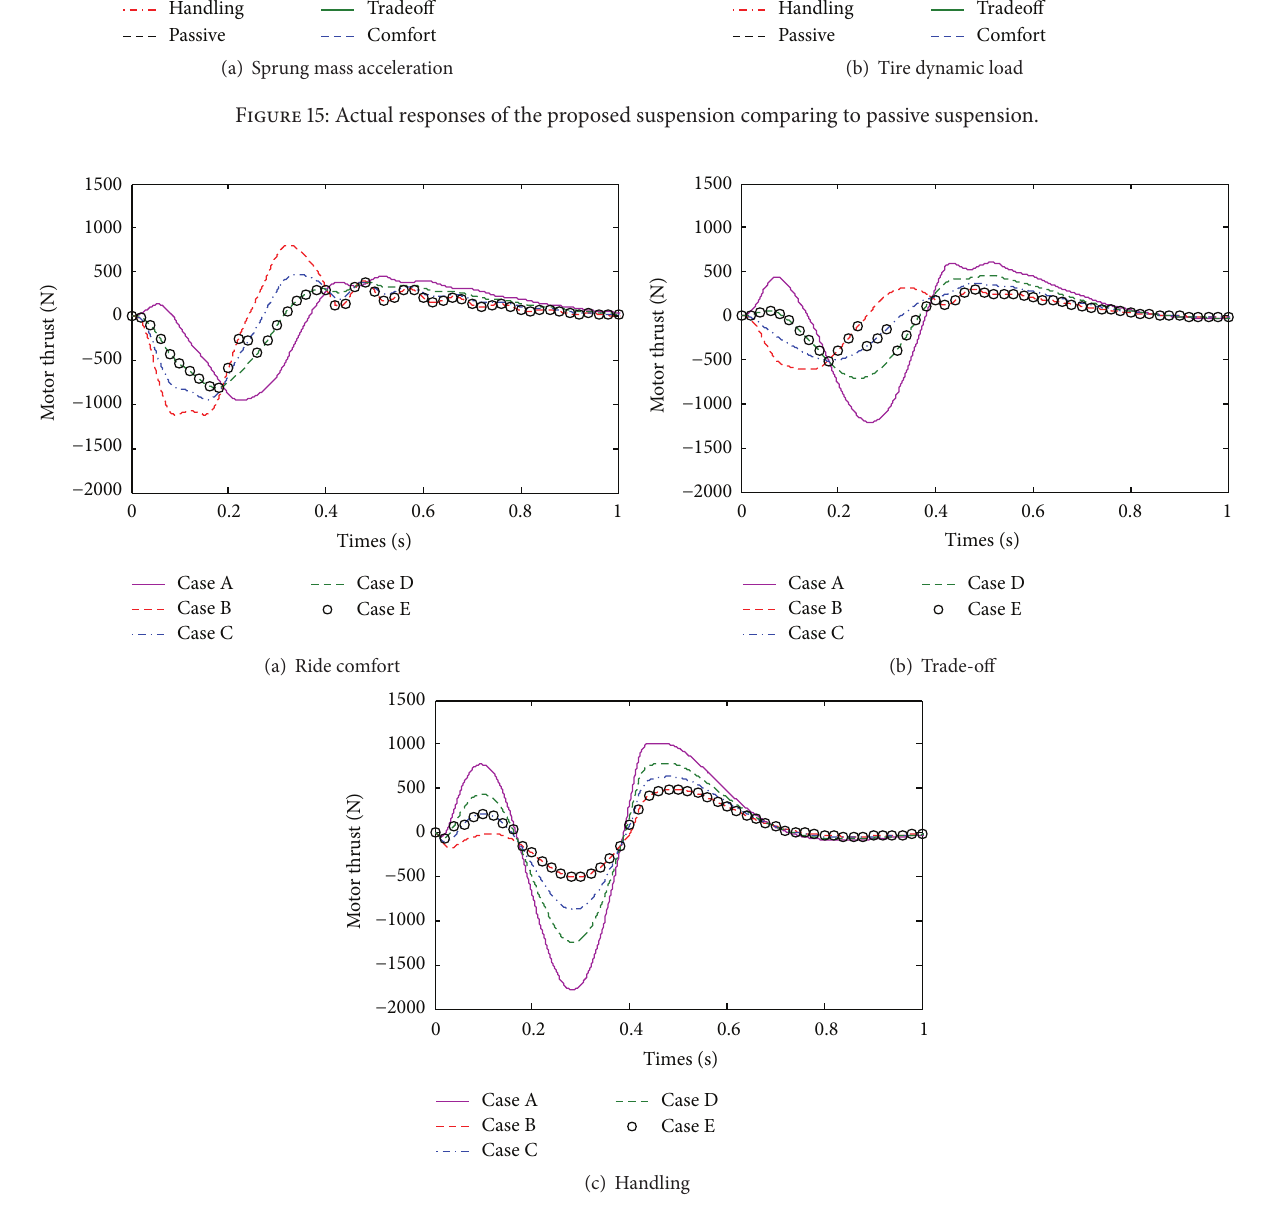
Figure 16: Motor thrust with different control